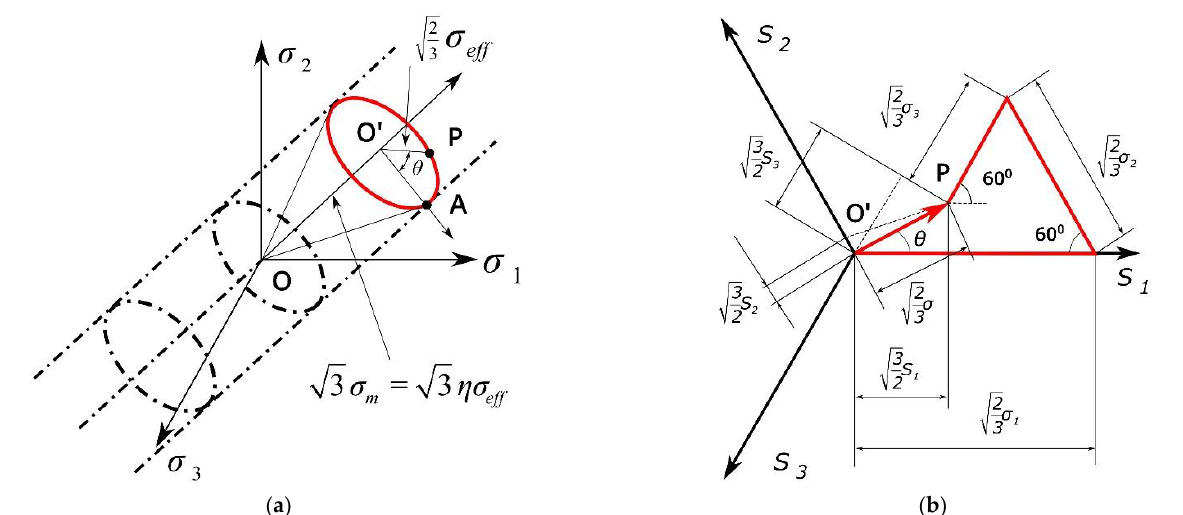
Figure 1. Components of the stress tensor in the principal stress space ( a ). Components of the stress tensor on the deviatoric plane ( b ).